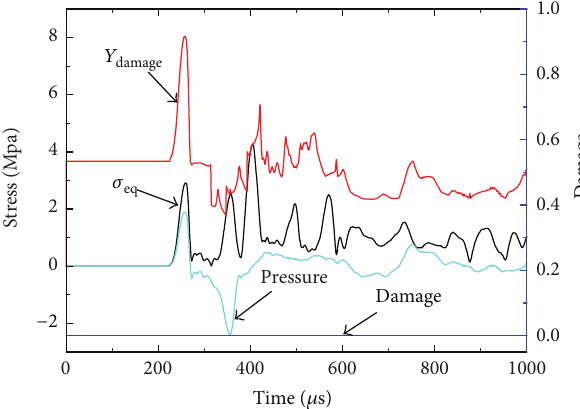
Figure 6: Instantaneous pressure, failure pressure, and damage versus time of target B.